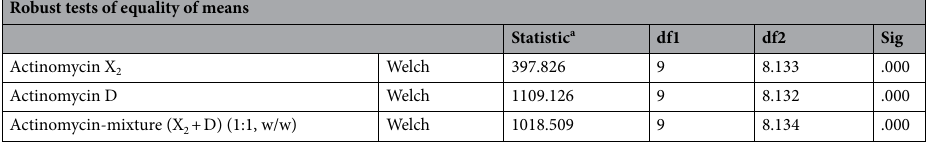
Statistic a df1 df2 Sig